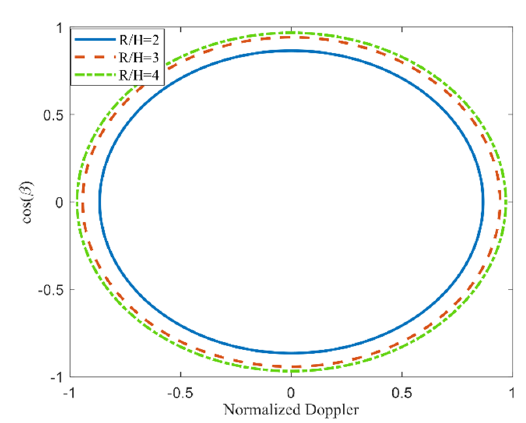
Figure 4. Clutter spectrum.